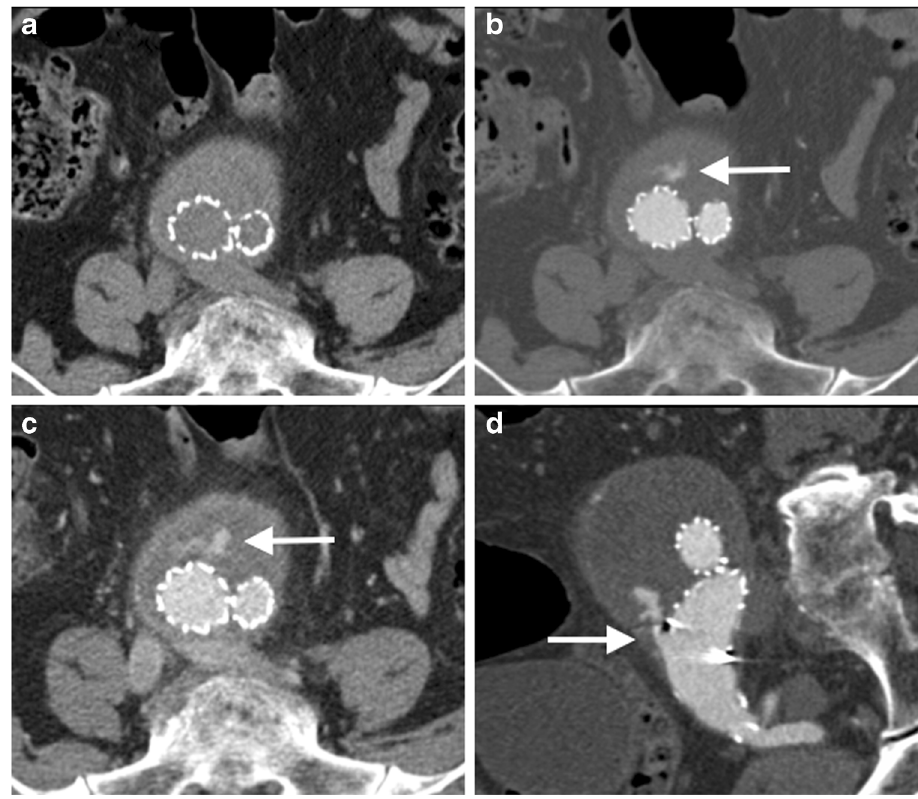
Fig.8 Selected images from a CT angiogram in a 55-year-old man undergoing imaging surveillance post abdominal aortic aneurysm endovascular stent graft repair (EVAR). Axial non-contrast ( a ), arterial phase ( b ) and 70 s delayed phase ( c ) images demonstrate io- dinated contrast material within the excluded aneurysm sac ( arrow ) consistent with an endoleak. Sagittal oblique MPR of the right common iliac artery ( d ) demonstrates the endoleak arising from the distal insertion point of the right iliac limb of the EVAR consistent with a type 1b